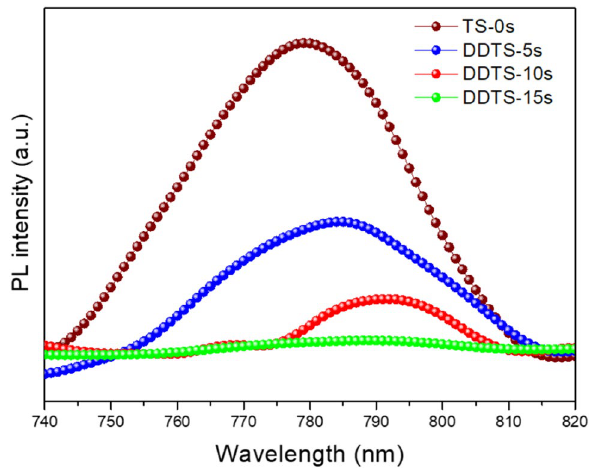
Fig. 5 Steady-state photoluminescence (PL) spectra of perovskite films with a regulated time delay (from 0 to 15 s)